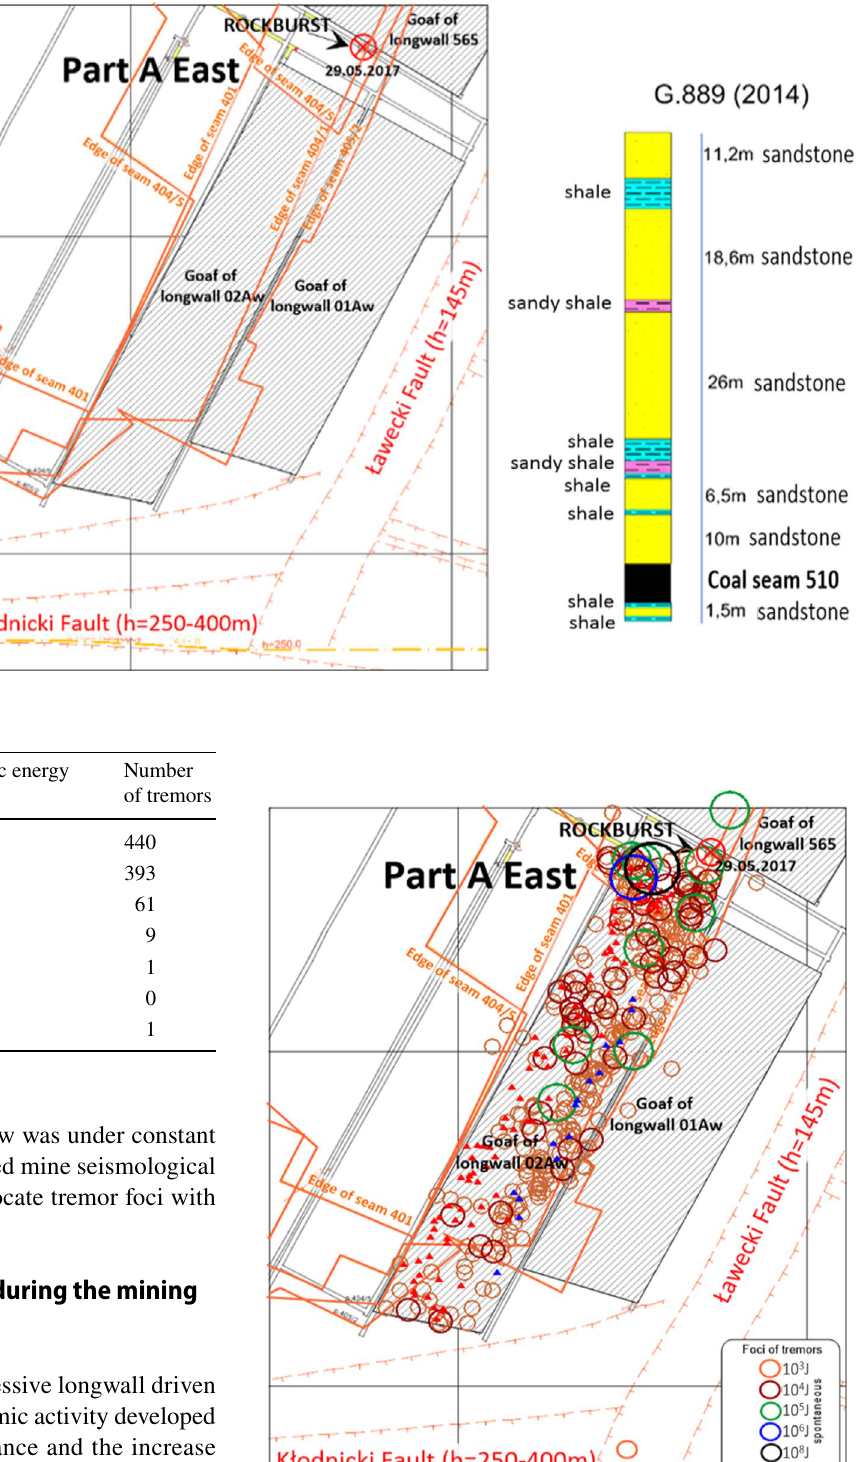
Fig. 2 Map of coal seam 510 with the location of longwall 02Aw and the geological profile of the roof strata